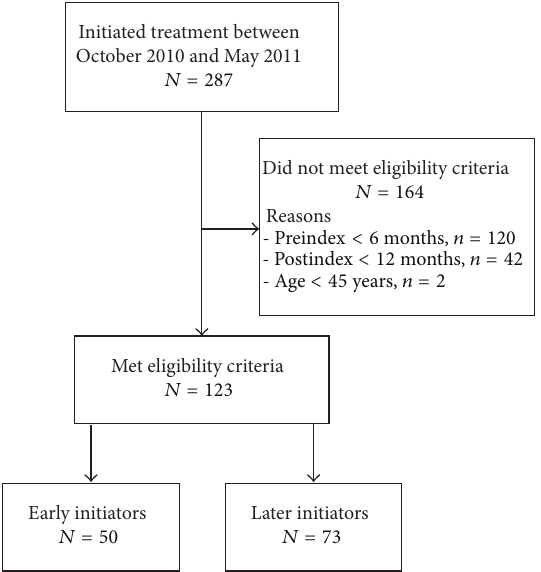
Figure 1: Patient disposition. Early initiators started treatment during months 1–4 of once-daily teriparatide availability, whereas later initiators started treatment during months 5–8 of once-daily teriparatide